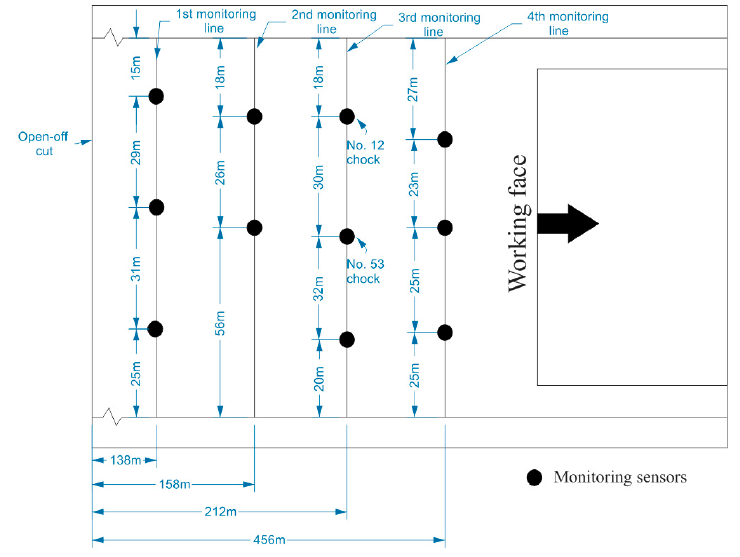
Figure 14. Locations of the monitoring sensors.